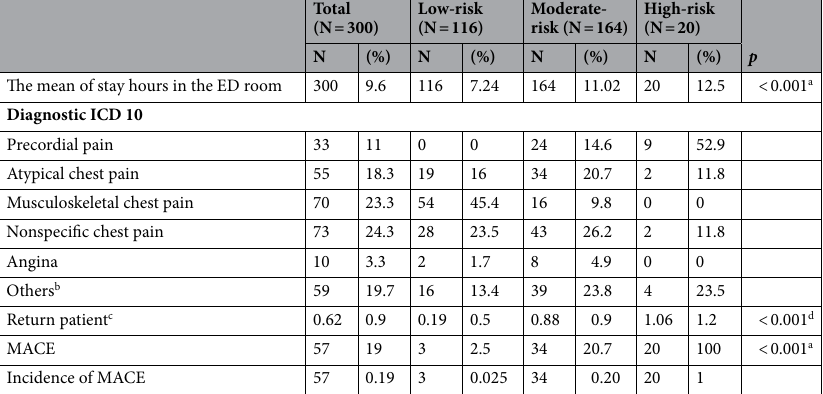
Table 2. The mean of stay hours in ED. Final diagnosis. Reconsultation for ANTCP. MACE estimation within 6-weeks. p p -value, MACE Major adverse cardiovascular events. a Chi-square test. b Other diagnosis: gastric pathology (32%), hepatobiliary pathology (19%), pulmonary pathology (13%), pancreatic pathology (11%), pleura pathology (7%), pericardial disease (5%), others (13%). c Number of return patient consultations after discharge within 6-weeks. d Non-parametric Kruskal–Wallis test.